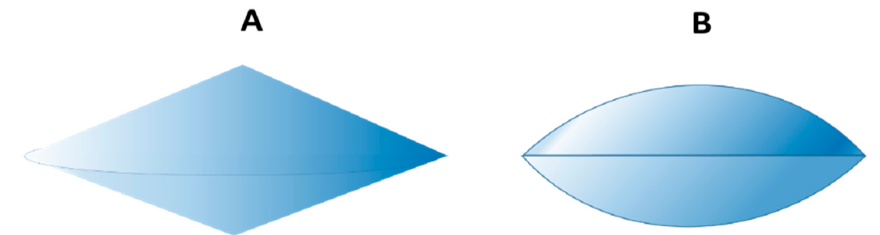
Figure 1. Nanoparticle shapes: ( A ) bi-cone, ( B ) disc.